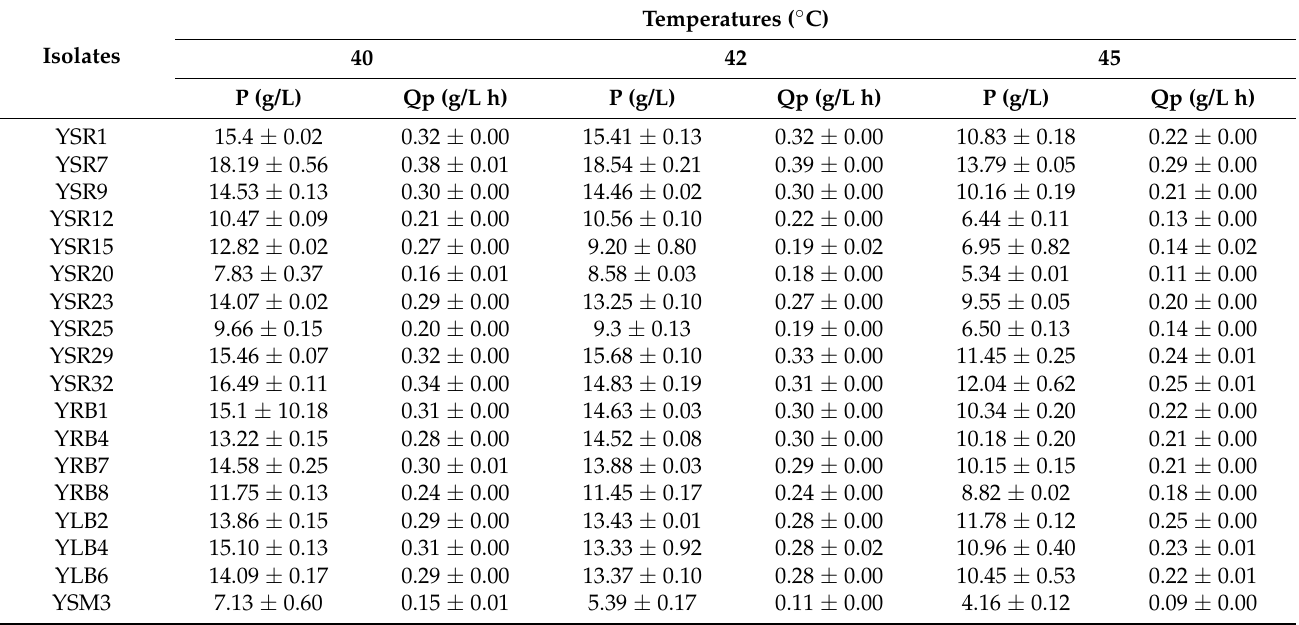
Table 2. Ethanol production potential of the selected yeast isolates at high temperatures using 50 g/L glucose as substrate.